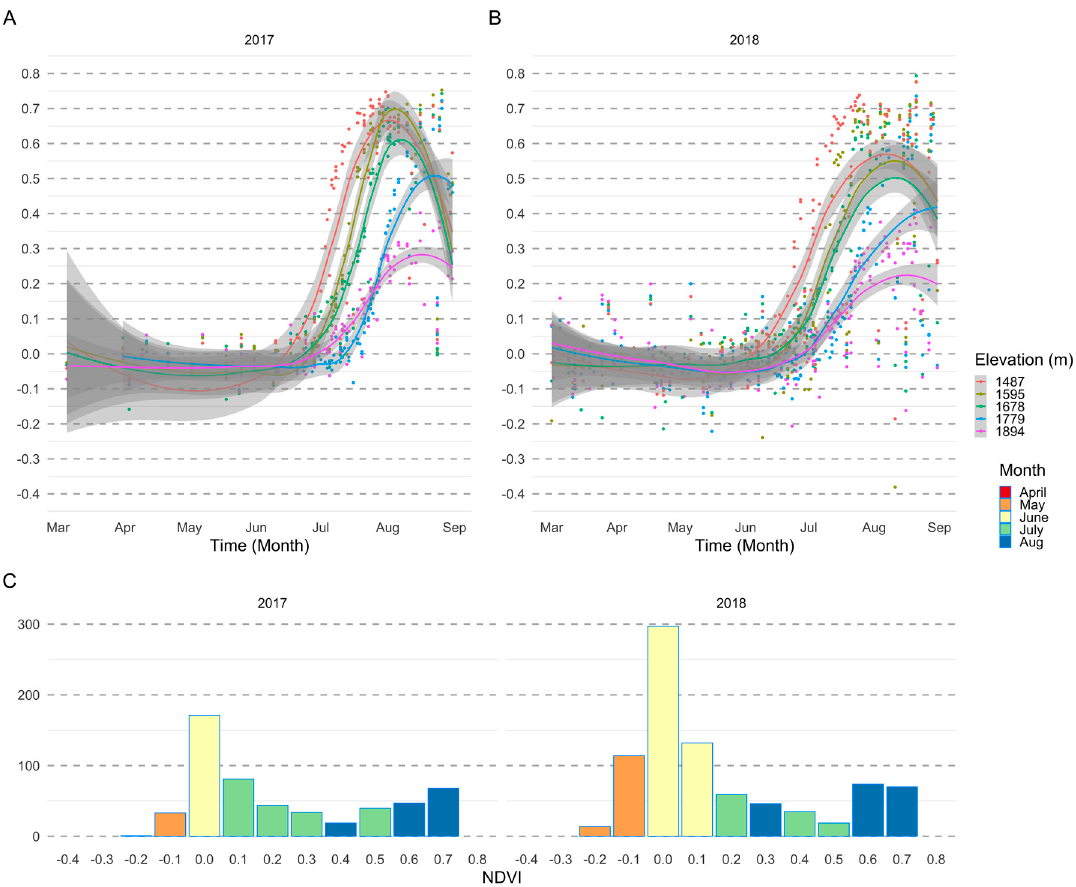
Figure A4. NDVI curve (loess smoothing) using Planet reflectance for years 2017–2018, showing the peak green-up around late July and also showing the phase lag by elevation. ( A ) 2017 NDVI values going from − 0.2 to 0.8 capturing snow on the ground to flowering; also, notice the lag in peak NDVI confirming the snow-melt lag that is driven by elevation. ( B) Similar patterns as 2017, 2018 NDVI values going from − 0.2 to 0.8, capturing snow on the ground to flowering; also, notice the lag in peak NDVI confirming the snow-melt lag that is driven by elevation. ( C ) Histogram of NDVI values binned by year with the average month that it was observed in shaded.